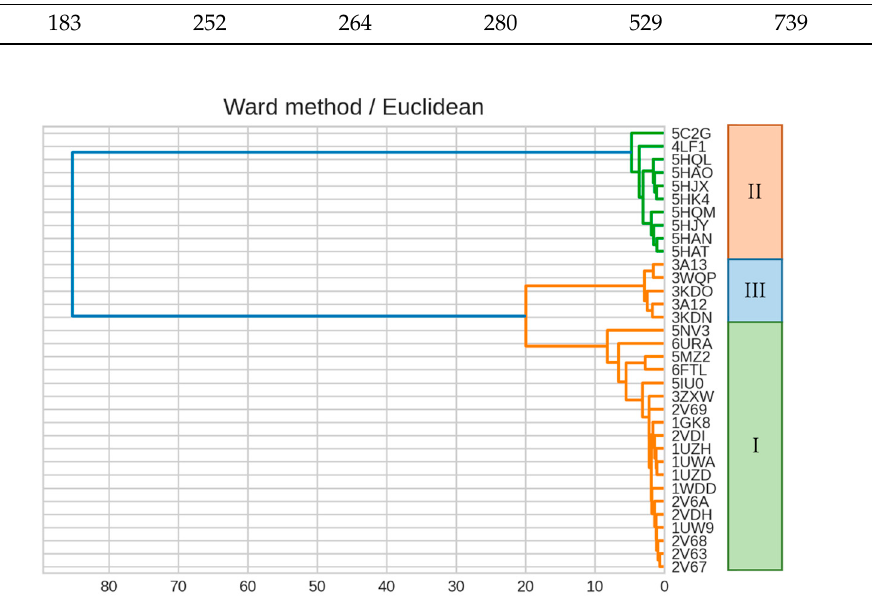
Figure 13. Dendrogram showing the clustering result using Ward’s method. Color coding is set at 60% of the maximum Euclidean distance. The dendrogram was generated using top 120 sites for the second left-singular vector using normalized IFIE data.